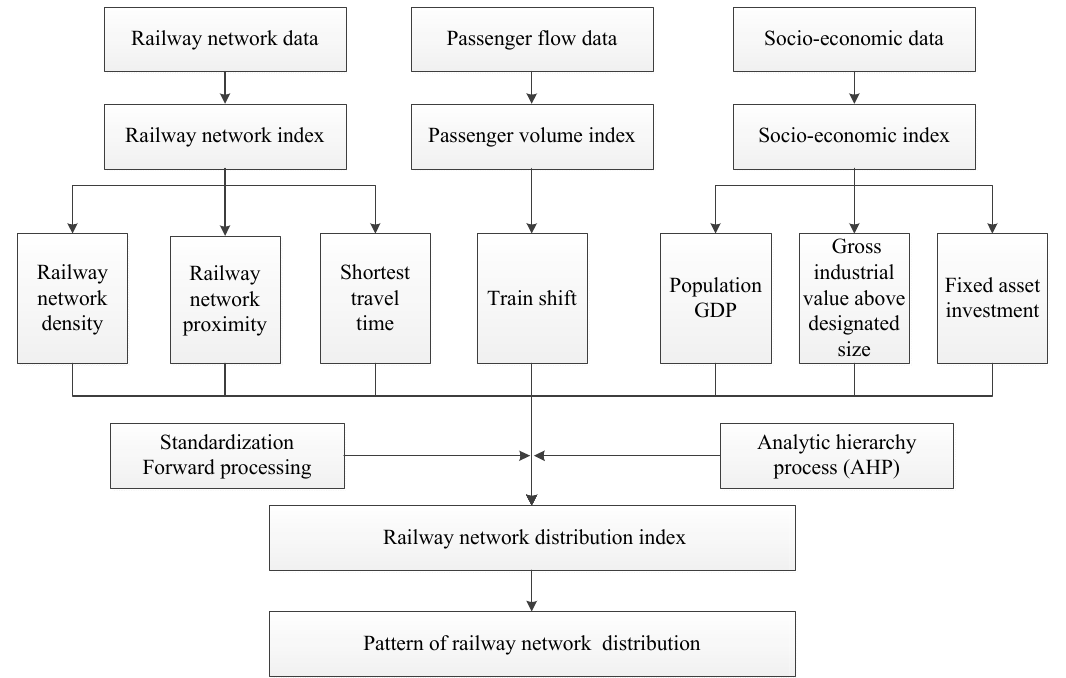
Figure 1. Technical flow for describing the distribution pattern of the railway network.